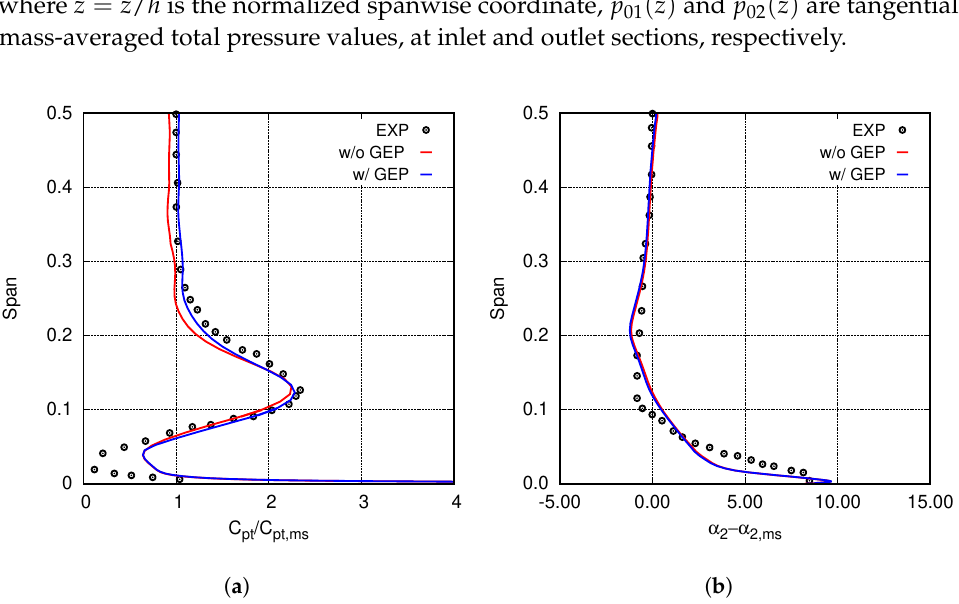
Figure 10. Spanwise distribution of ( a ) total pressure loss coefficient ( b ) blade-to-blade flow angle ( Re 2, is = 1.5 10 5 , x / C x , ms = ×